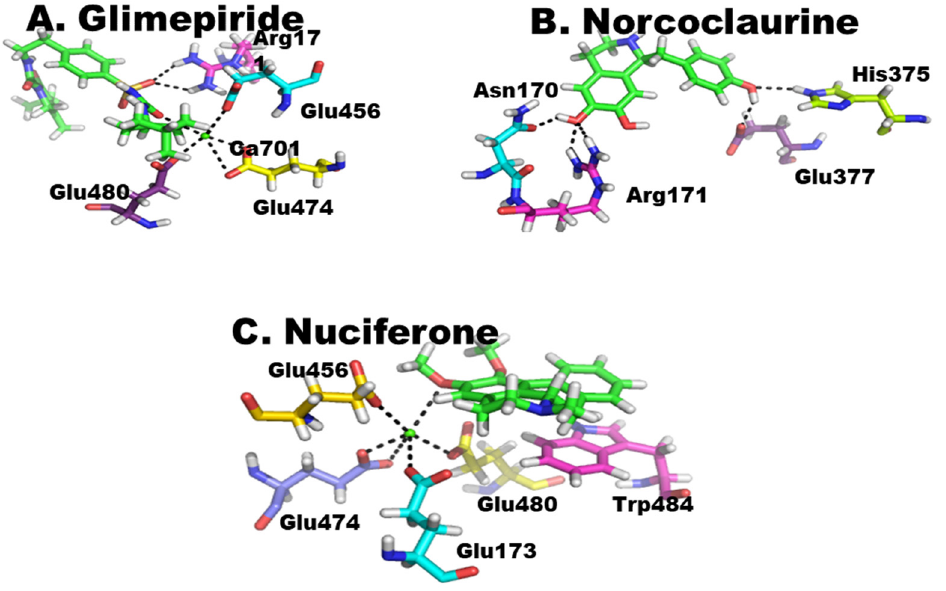
Figure 2. ( A – C ) Protein–ligand interaction of α -glycosidase. The green color shows the ligand.